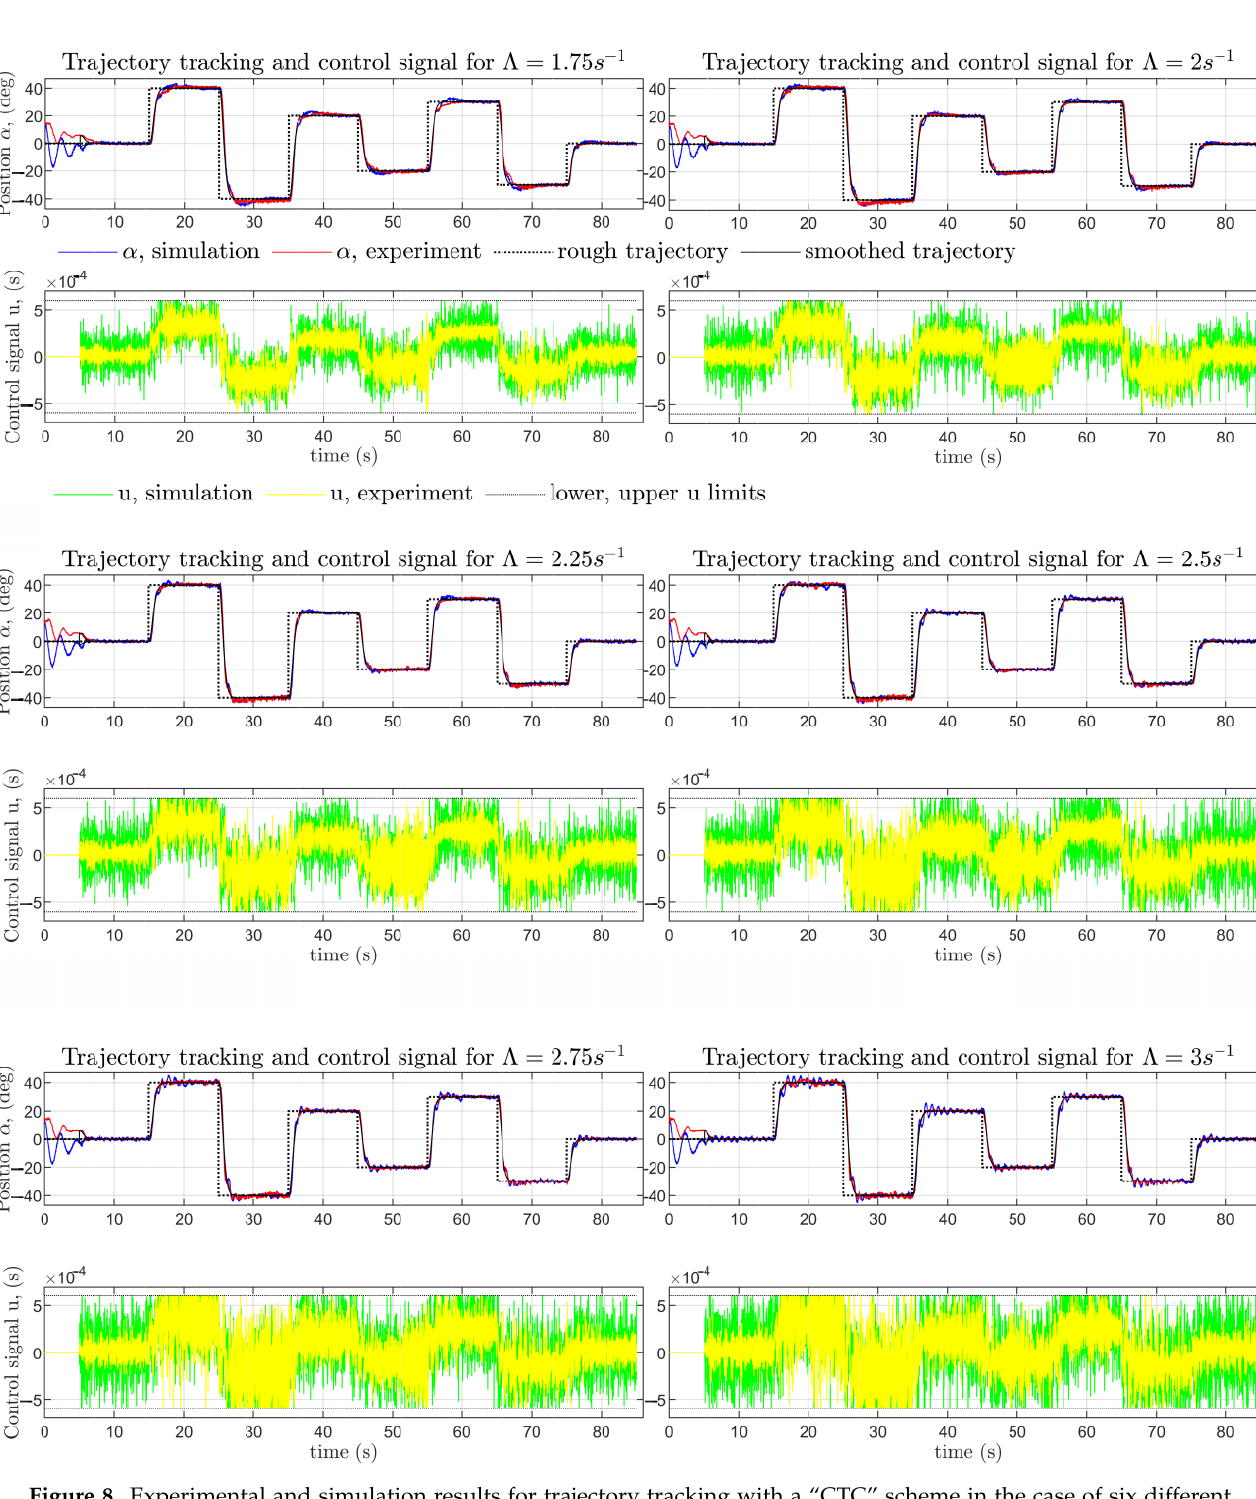
Figure 8. Experimental and simulation results for trajectory tracking with a “CTC” scheme in the case of six different Λ